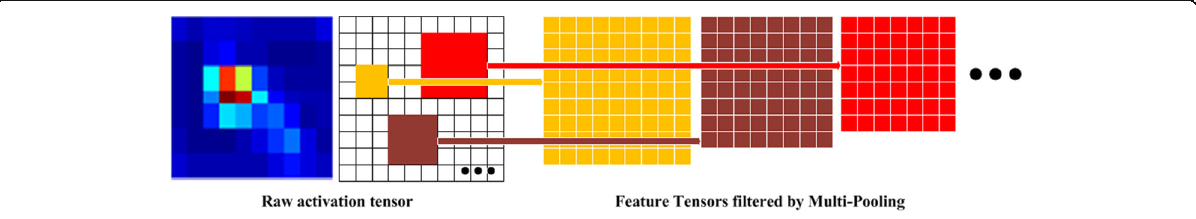
Fig. 2 Illustration of multi-pooling by different pooling window